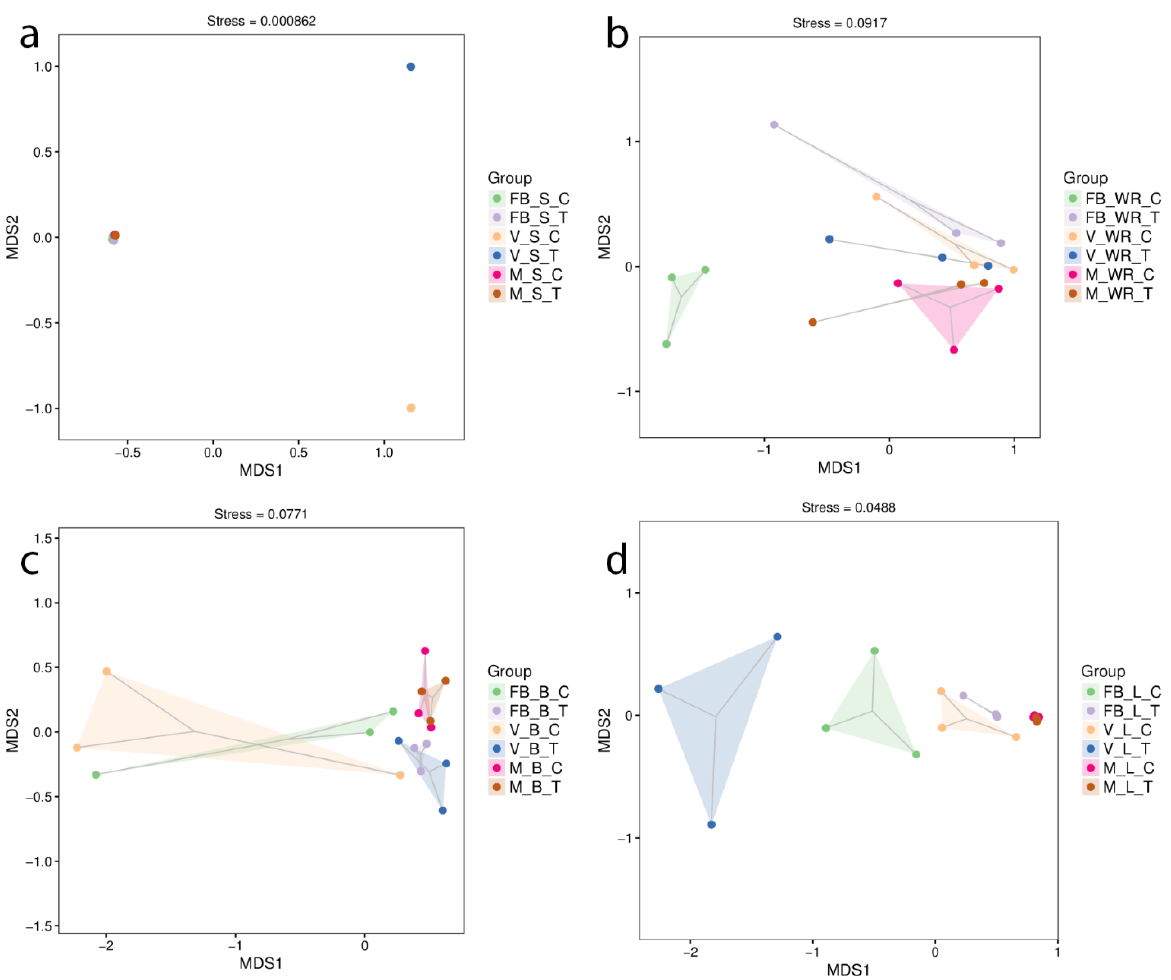
Figure 3. Non-metric multidimensional scaling (NMDS) for evaluation of microbial communities in samples from treated and control plants at full bloom, veraison and maturity. ( a ) Rhizospheric soil, ( b ) white roots, ( c ) leaves, and ( d ) berries.